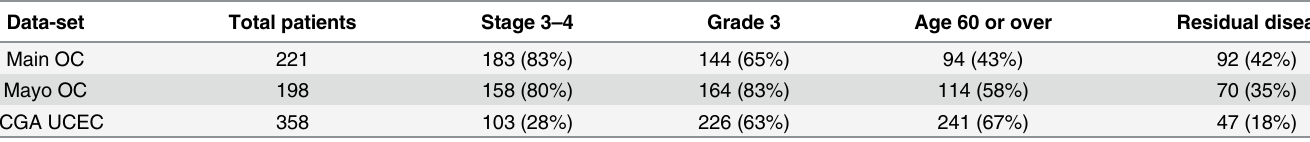
Table 2. Patient cohort details of the main DNA methylation data-sets